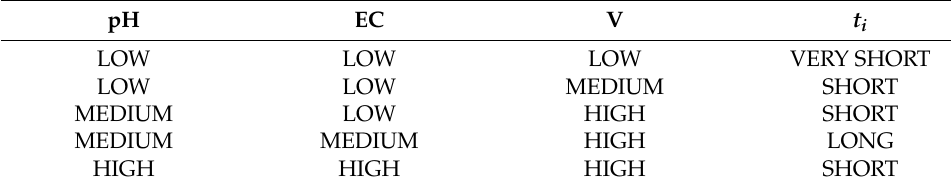
Table 4. Fuzzy rule structure with examples.